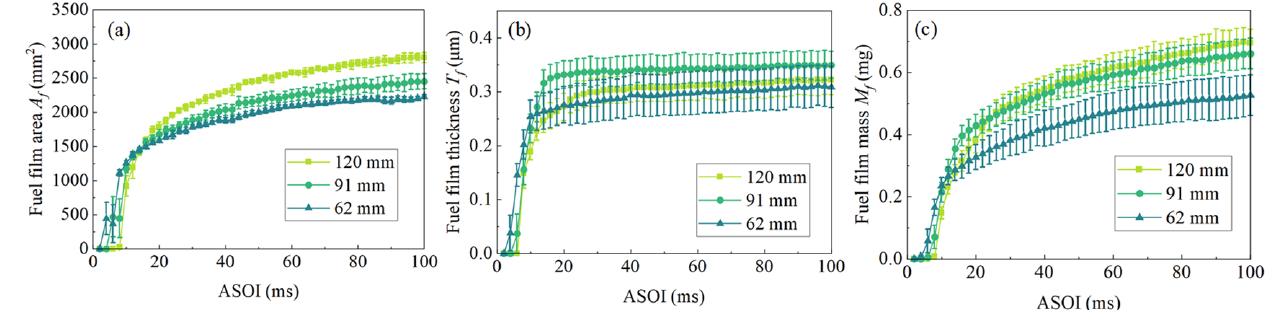
Figure 14. ( a ) Fuel film area A f , ( b ) Fuel film thickness T f and ( c ) Fuel film mass M f on the wall with temperature 293 K under different D imp .